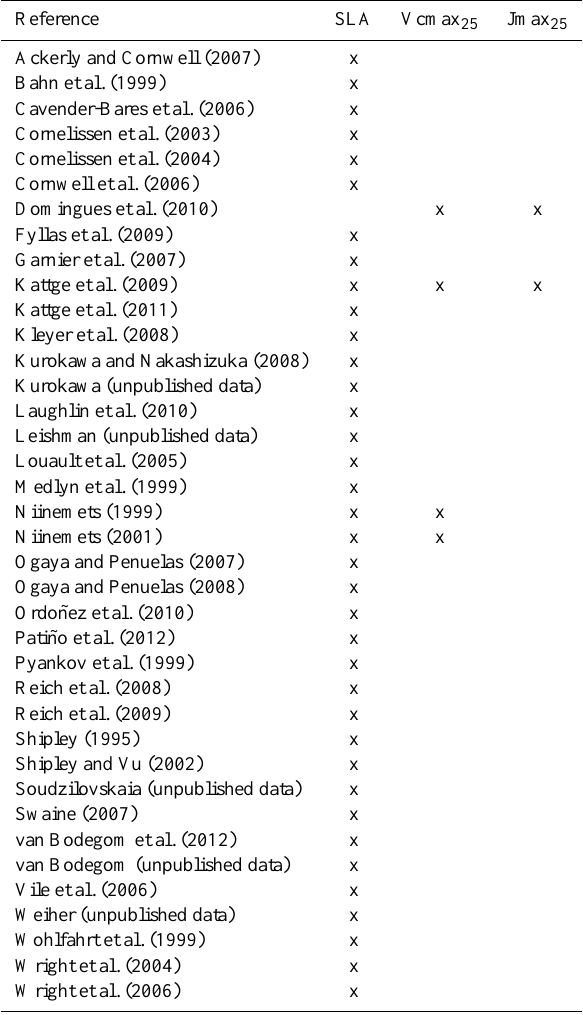
Table 1. References for trait data used in this